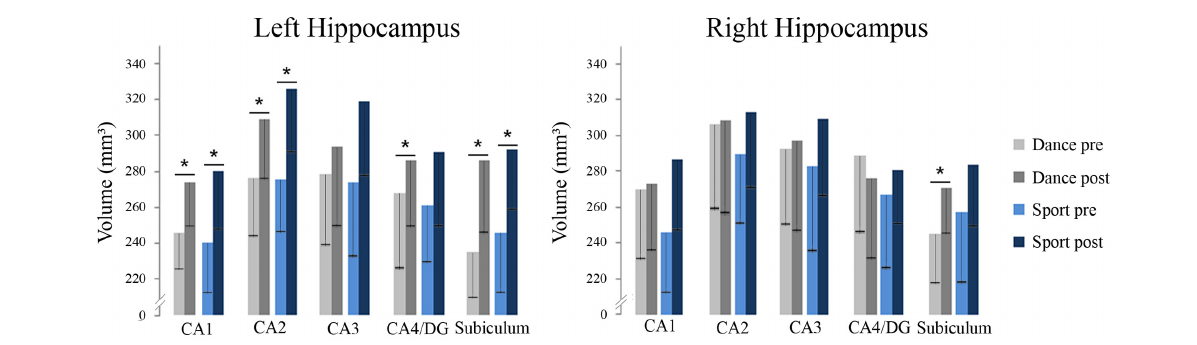
Frontiers in Human Neuroscience |